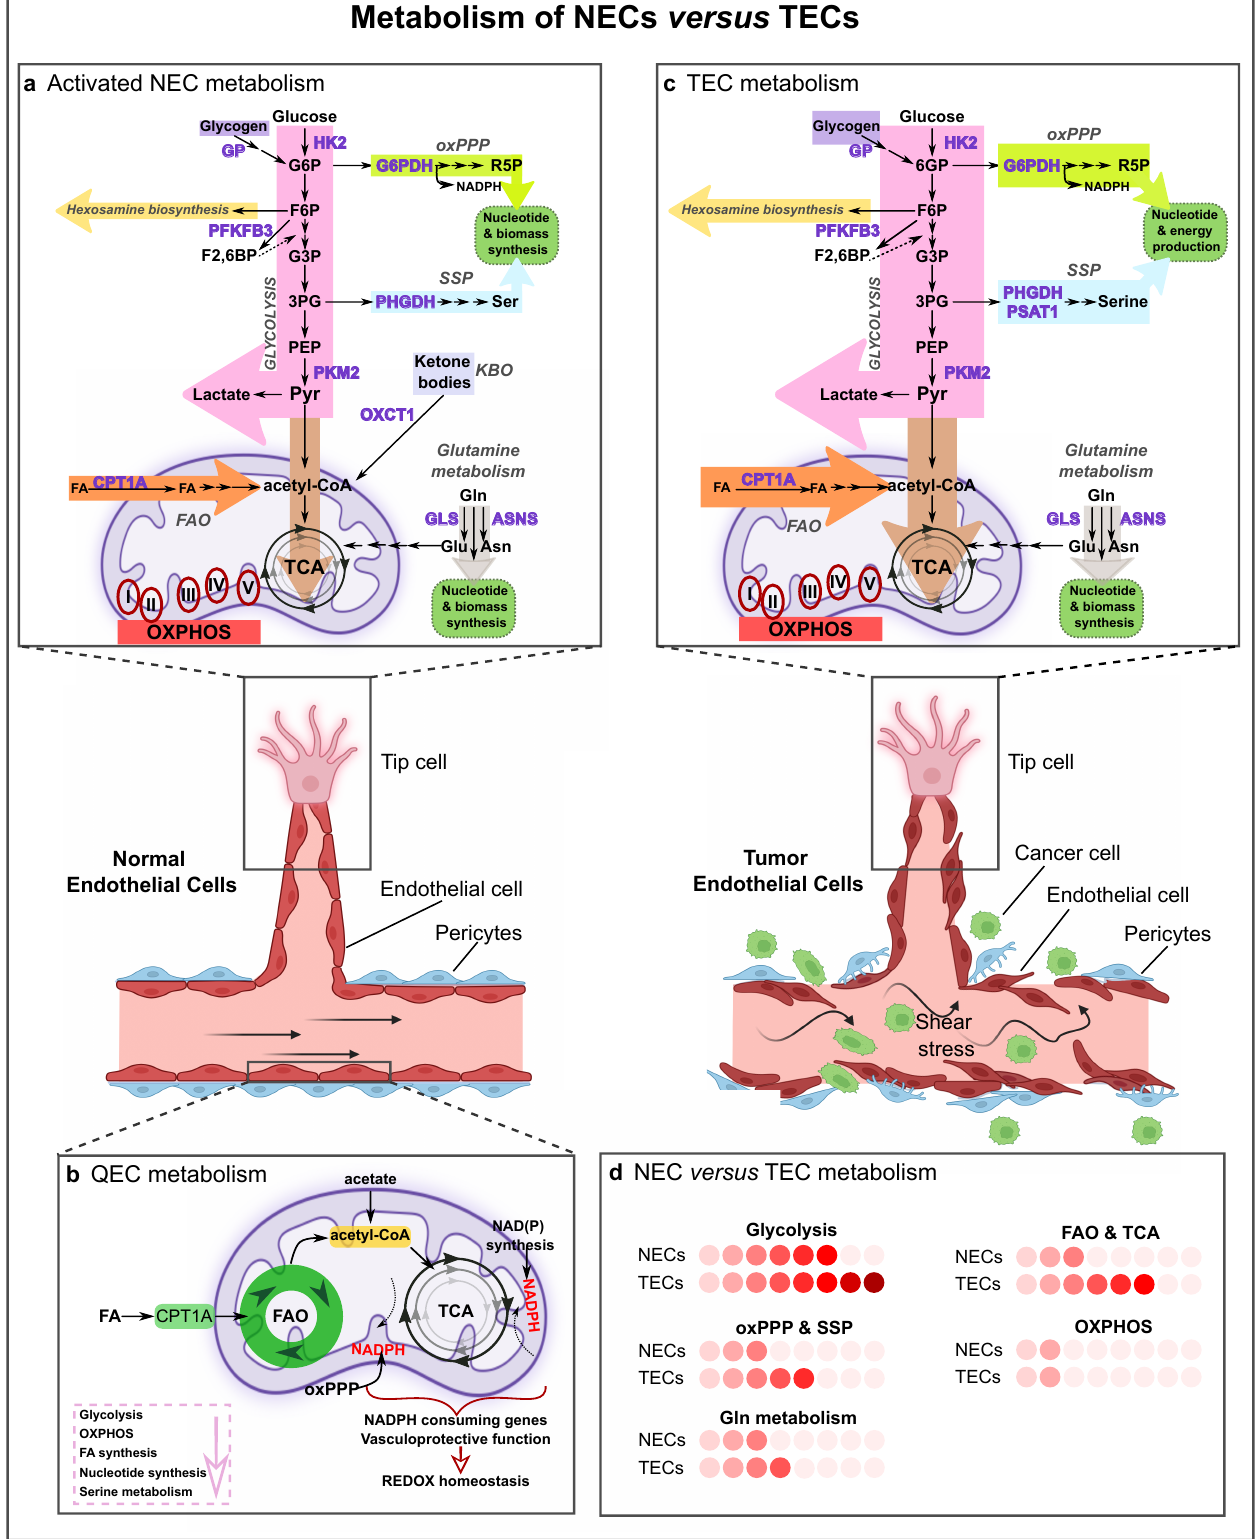
Figure 2. Metabolism of normal and tumor ECs. Graphical visualization of a normal and a tumor blood vessel with their metabolism. Normal vessels are characterized by a tightly adherent monolayer of ECs, intact basement membrane and rich pericyte coverage. Tumor vessels are lined by